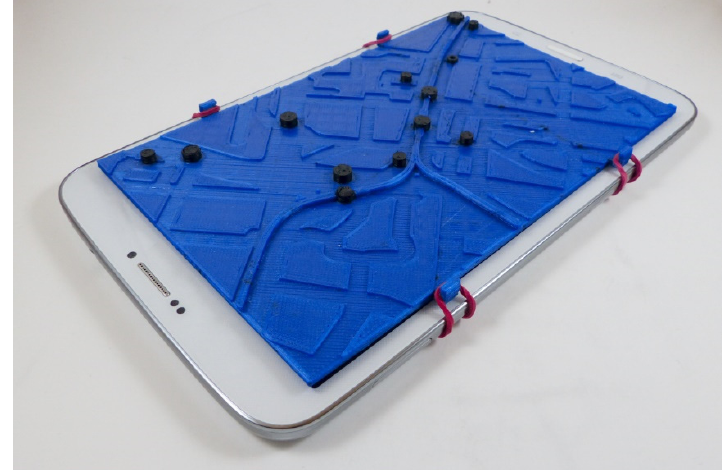
Figure 12. Final map of the Public Transport type capturing part of Ostrava‘s city center.